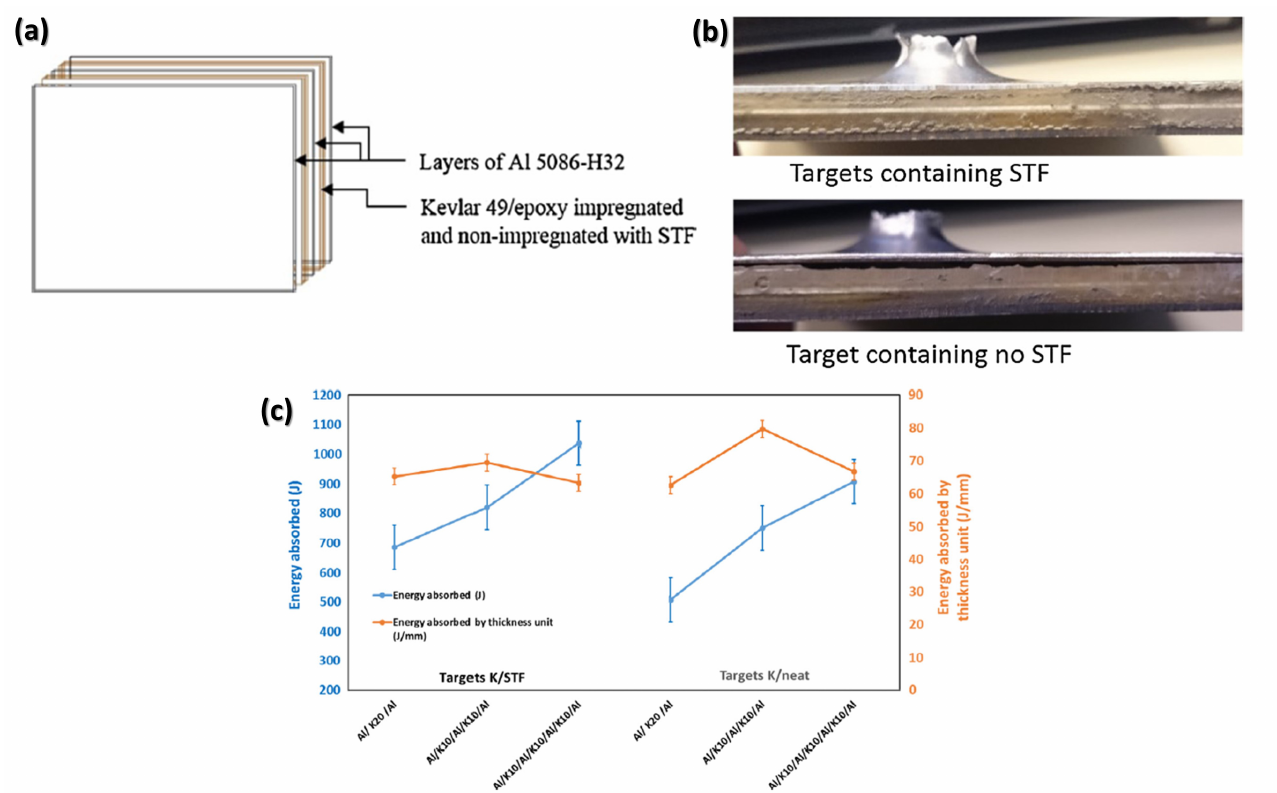
Figure 11. ( a ) Schematic of the arrangement of the Kevlar and Al layers; ( b ) side view of the samples after the ballistic test indicating the integrity of the samples; ( c ) relation between energy absorption by thickness unit and dissipated energy after ballistic impacts at the specimens. Adapted with permission from Ref. [124]. Copyright 2016,